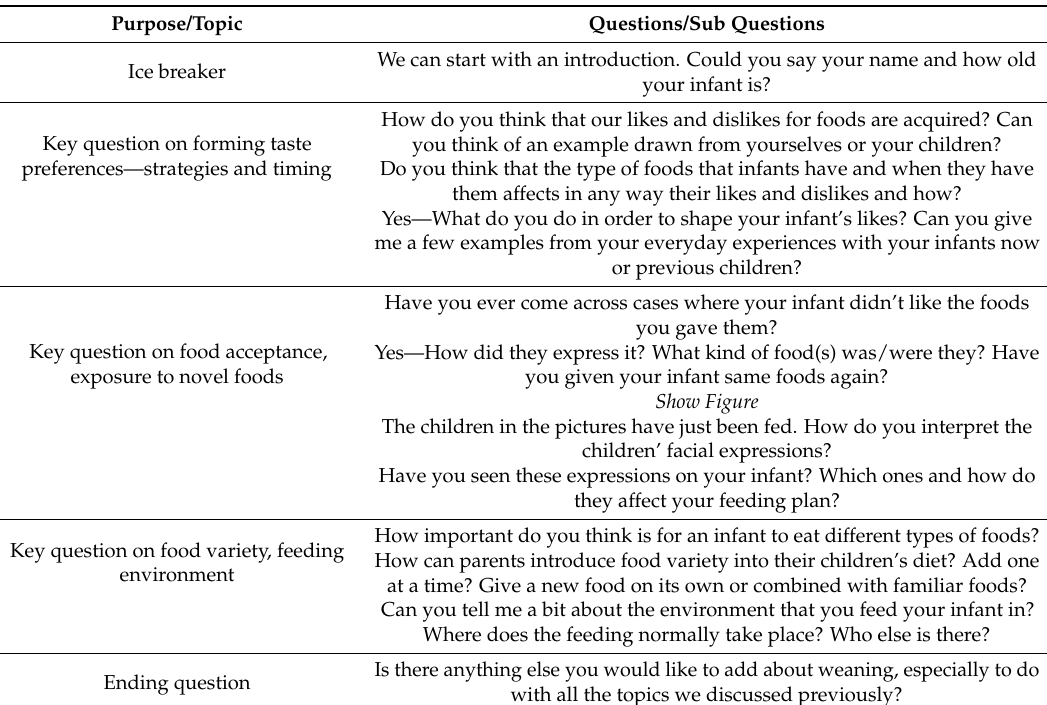
Table 1. Outline of the Focus Group Topic